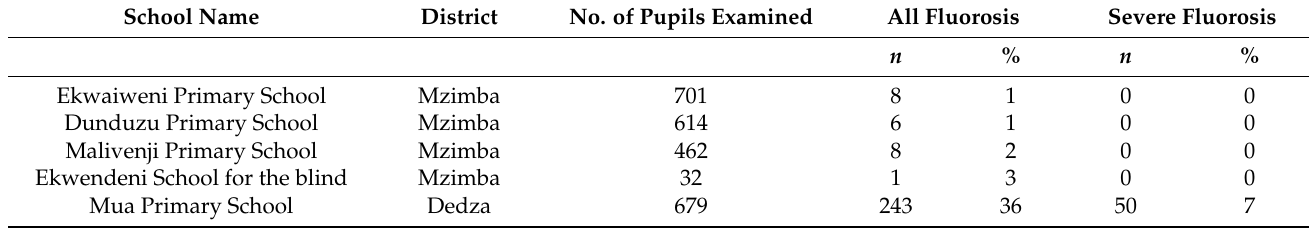
Table 3. Number and Percentage of children with dental fluorosis and severe dental fluorosis at each of the schools which were sampled by both dental and groundwater sampling teams. Percentage values for ‘all fluorosis’ and ‘severe fluorosis’ reflect the proportion of the total number of pupils examined at each school in each case.